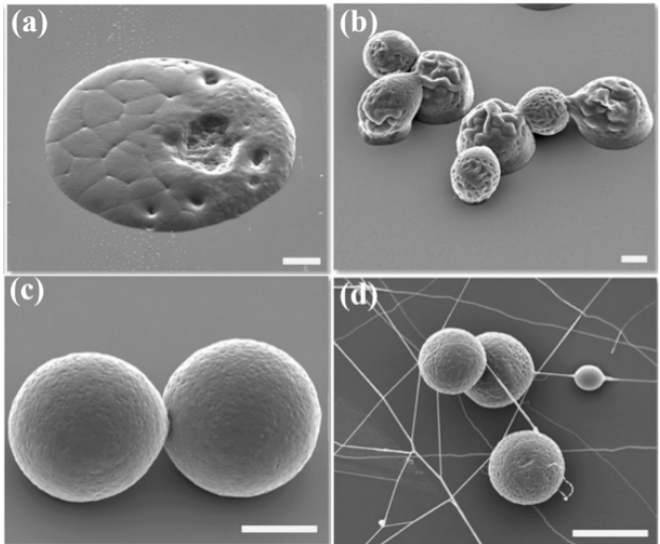
Figure 6. Scanning electron micrographs of dried PCL microparticles. PCL concentration in chloroform is: ( a ) 5%, ( b ) 7.4%, ( c ) 8.7%, ( d ) 9.6% ( w/v ). Electrospraying conditions are 26 G for needle